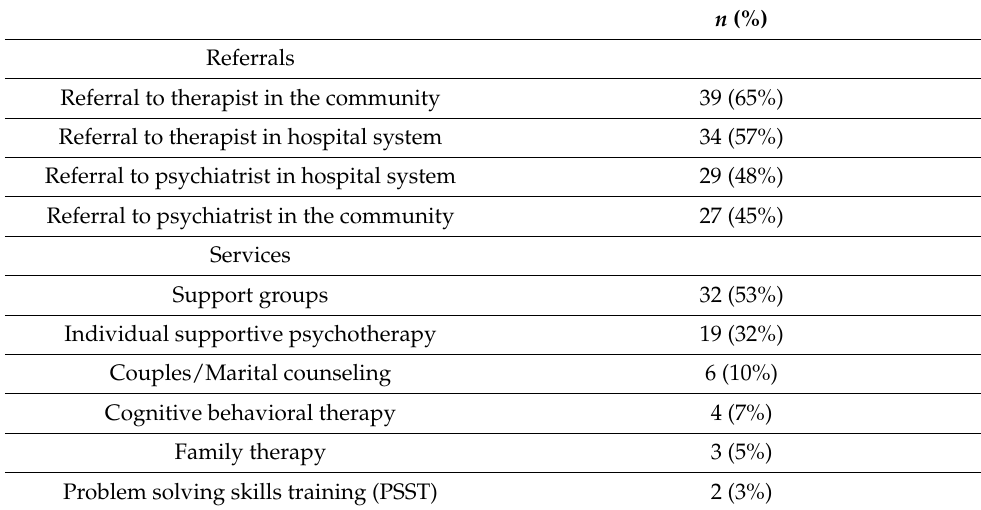
Table 4. Mental health treatment referrals and services offered ( n =